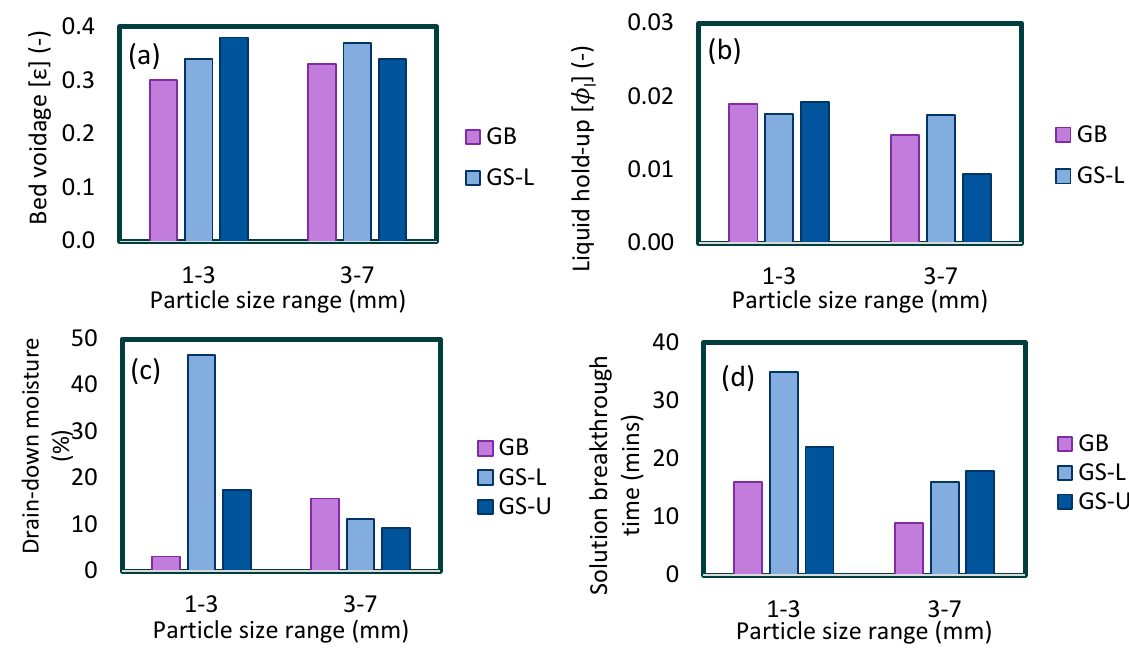
Figure 8. ( a ) Bed voidage, ( b ) total liquid hold-up, ( c ) 24-h drain-down moisture as the percentage of total liquid hold-up and ( d ) solution breakthrough time characterisation data for beds composed of different size fractions of GBs and GSs. Key: L—lower size range; U—upper size range; GB 1-3 size range (GB-2) and GB 3-7 size range (GB-5); GS-L 1-3 size range (GS-1-2) and GS-L 3-7 size range (GS-3-5); GS-U 1-3 size range (GS-2-3) and GS-U 3-7 size range (GS-5-7).